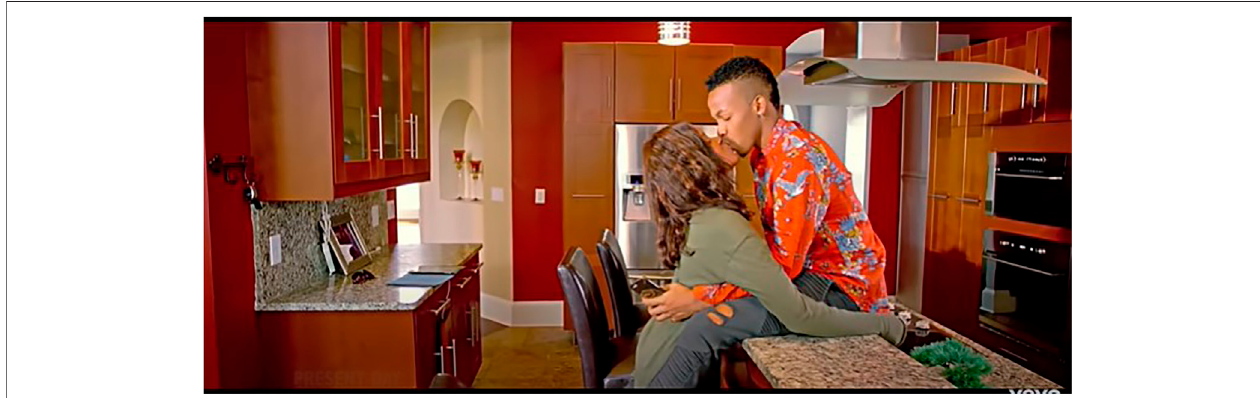
FIGURE 1 | Visual display of heterosexual romantic relations in Tekno ’ s “ Where ” music video [screenshot taken from Where (Of fi cial Music Video): https://www. youtube.com/watch?v (cid:1) ooFAF18L5wQ].